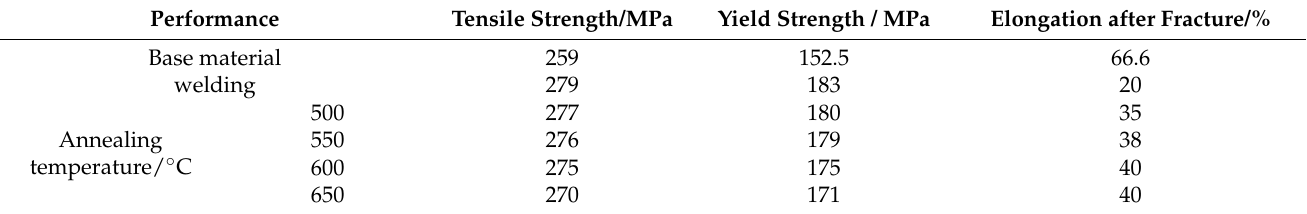
Table 3. Mechanical performance of TA1 titanium plate corresponding to each